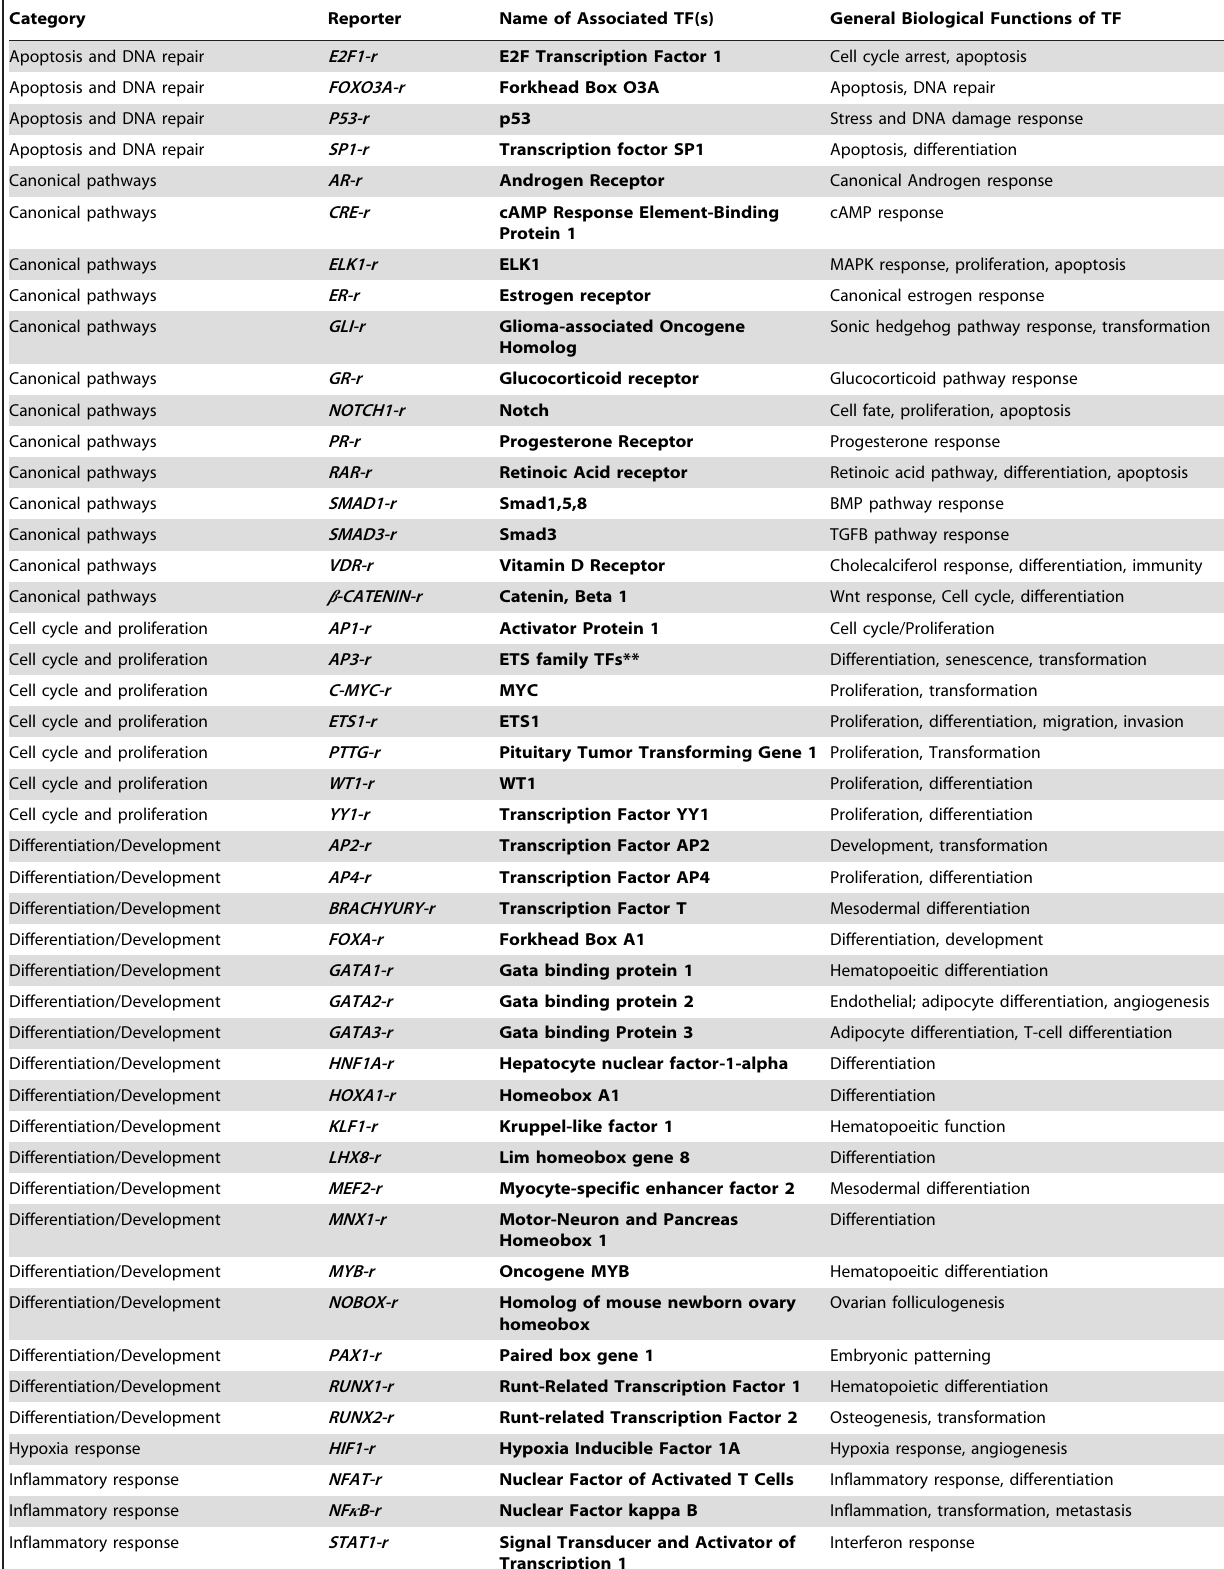
Table 1. TF reporters used in arrays grouped by associated TF biological